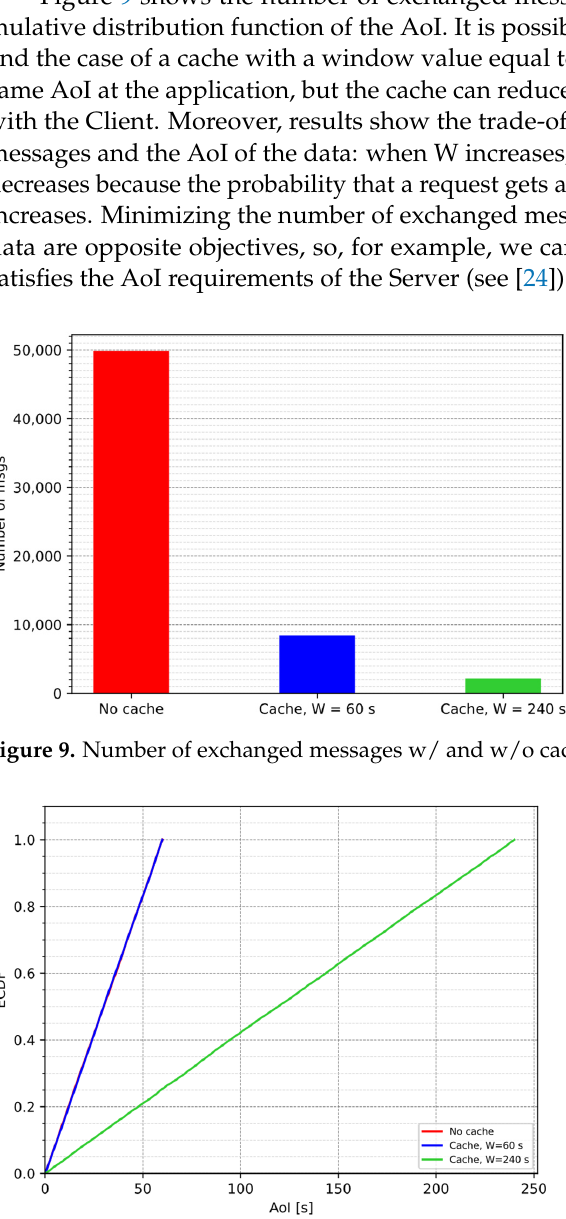
Figure 10. AoI empirical CDF w/ and w/o cache, λ = 1/10 s − 1 .